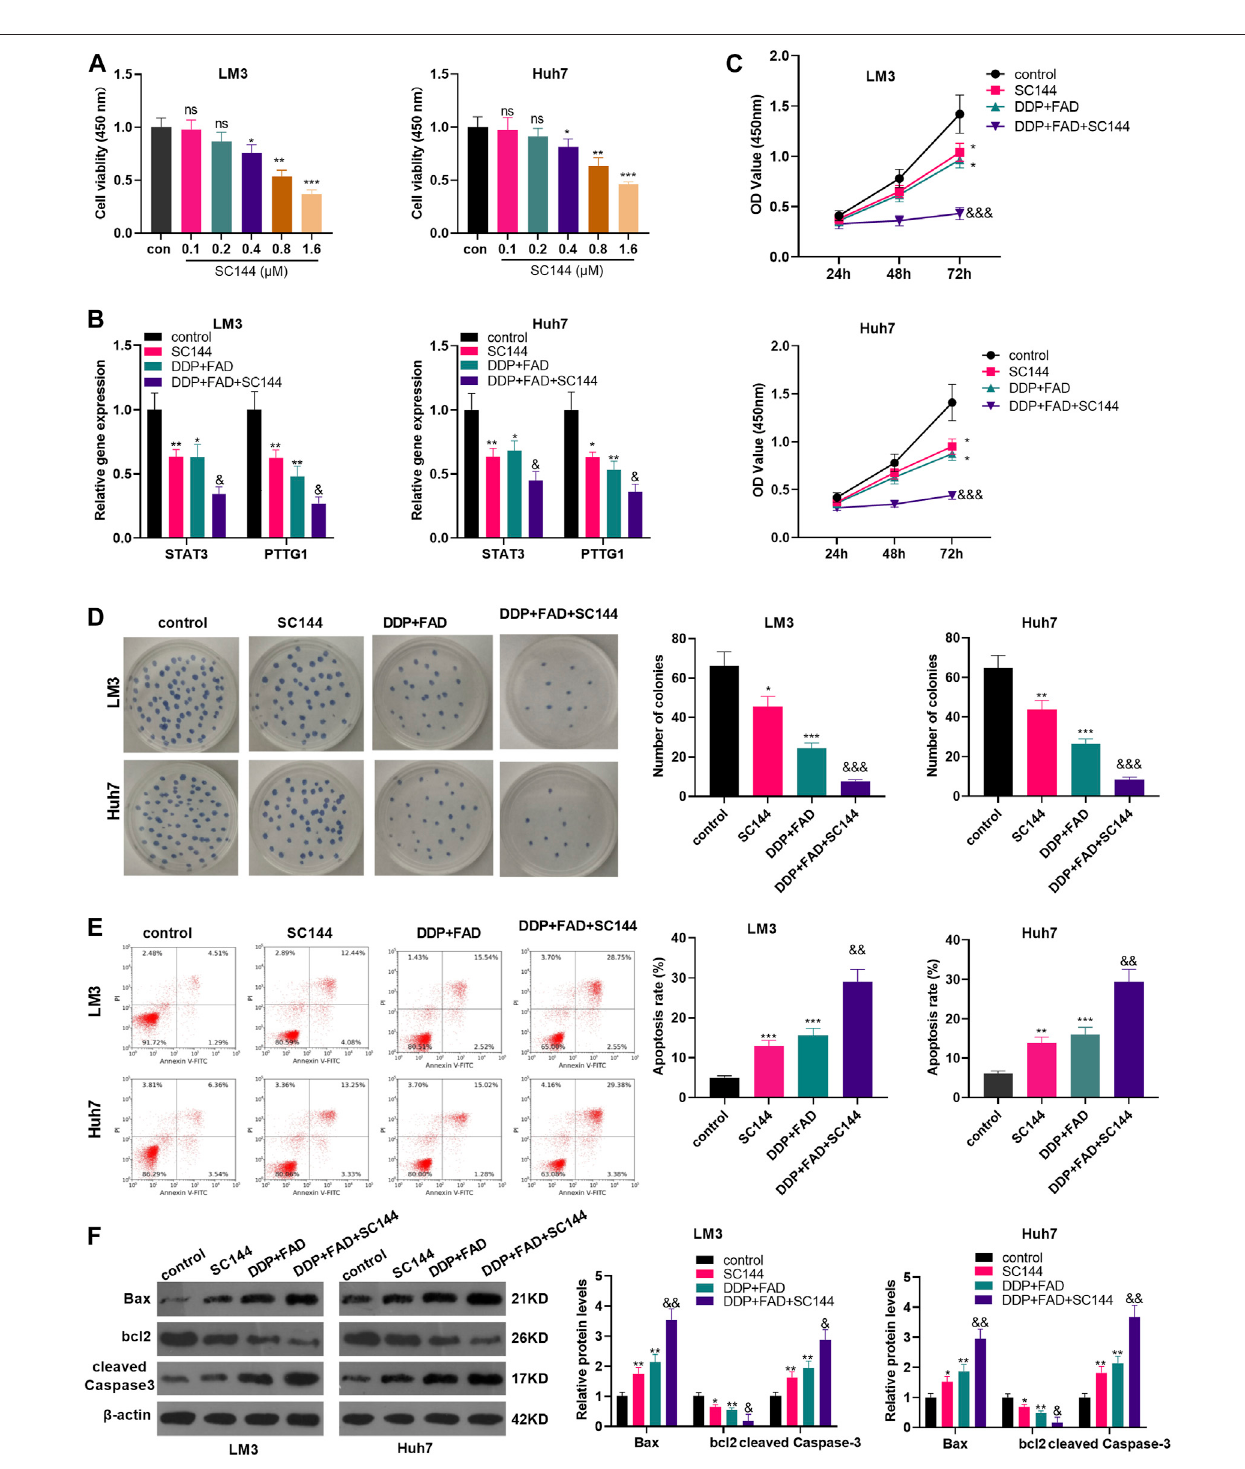
FIGURE 5 | Inhibition of STAT3 strengthened the role of FAD-enhanced chemosensitivity of HCC cells to DDP. HCC cell lines (Huh7 and LM3) were treated with different doses of STAT3 inhibitor SC144 (0.1 – 1.6 µM) for 24 h. (A) . The cell proliferation was detected by CCK8 assay. HCC cell lines (Huh7 and LM3) were dealt with the DDP (2 μ g/mL) and FAD (10 µM) and/or the STAT3 inhibitor SC144 (0.6 µM) for 24 – 72 h. (B) . qRT-PCR was used to detect the STAT3/PTTG1 expression. (C, D) . CCK-8 assay and colony formation assay was employed to test cell proliferation. (E) . FCM was conducted to monitor apoptosis. (F) . Expression of Bax, bcl2, cleaved Caspase3 was detected by WB. * p < 0.05, ** p < 0.01 (vs. DDP group). & p < 0.05, && p < 0.01, &&& p < 0.001 (vs. DDP + FAD group). N (cid:2) 3.